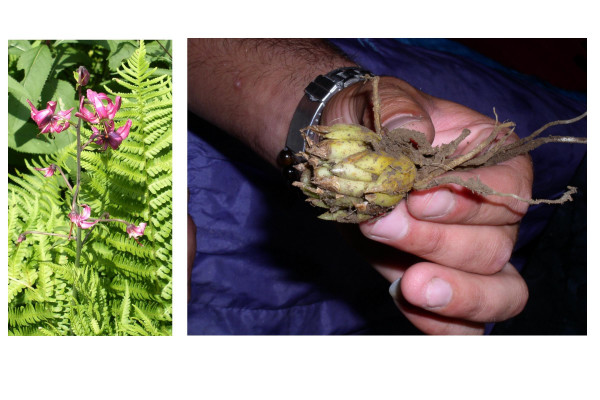
Lilium martagon L.